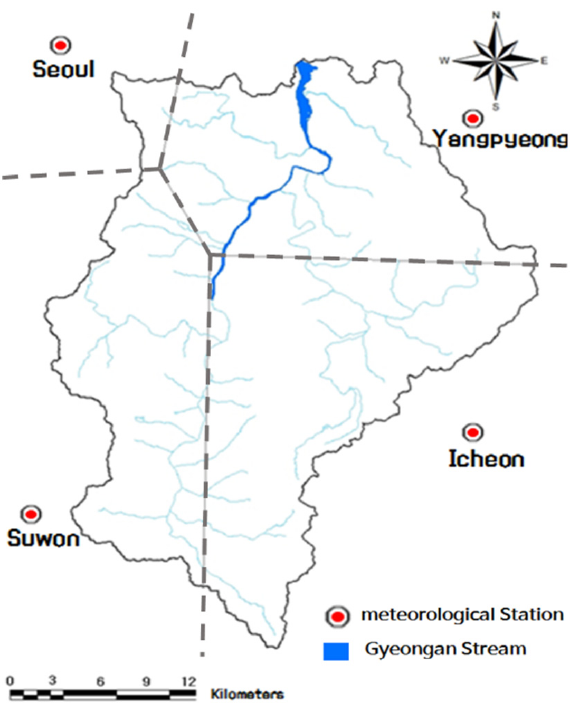
Figure 1. Gyeongan stream basin in Namhan river, Korea; broken lines mark the Thiessen network.